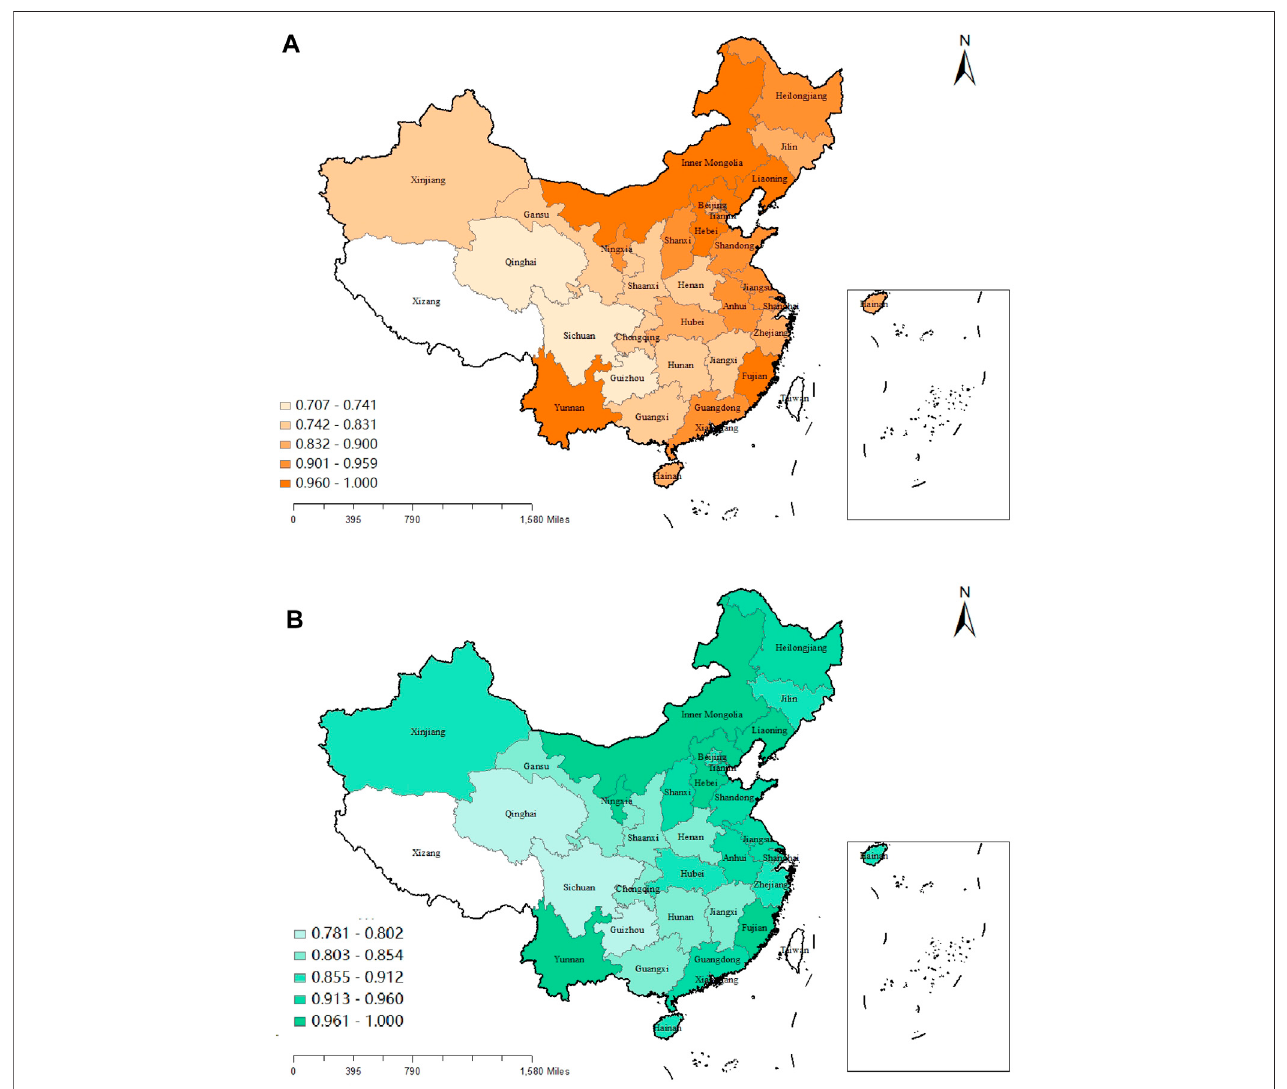
FIGURE 10 | (A) Average annual installed capacity ef fi ciency in various regions. (B) Average annual carbon emission reduction ef fi ciency in various